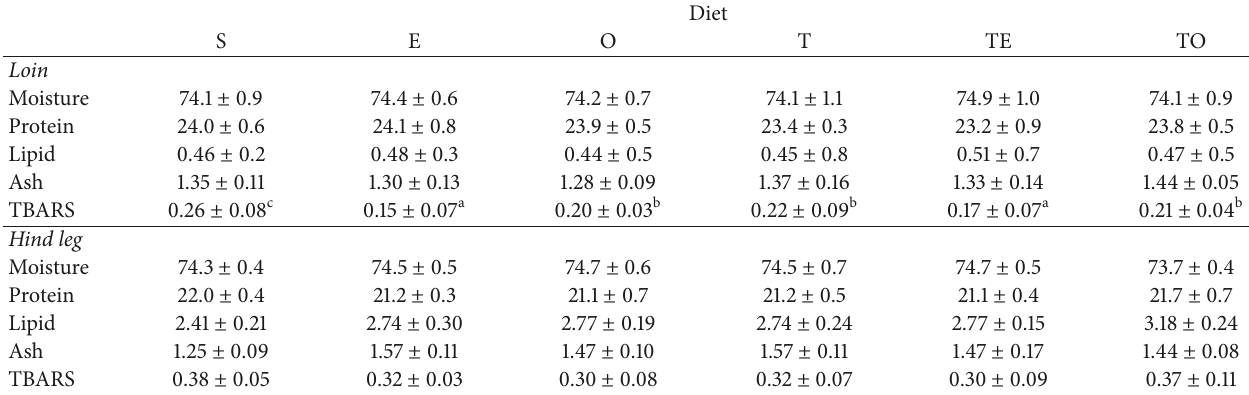
Table 3: Effect of the dietary treatment on the proximate composition (g/100g meat) and TBARS (mg MDA/kg meat) contents of rabbit loin and hind leg. Diet S E O T TE TO